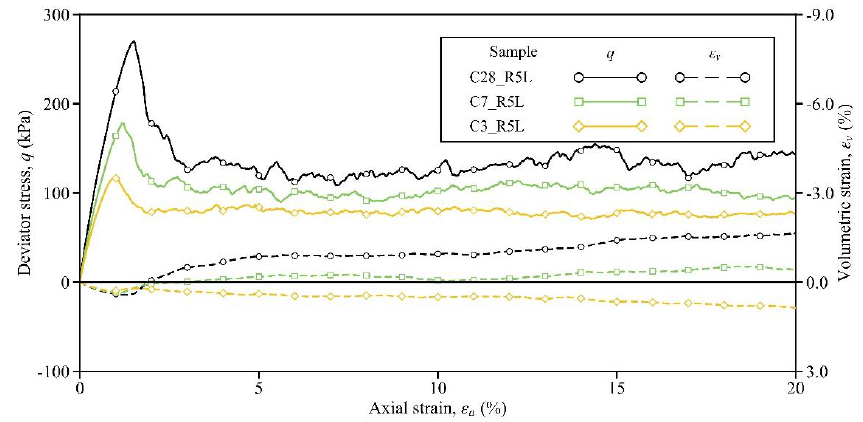
Figure 3. Influence of the curing time on the stress – strain response. Table 3. Responses of the samples with different initial